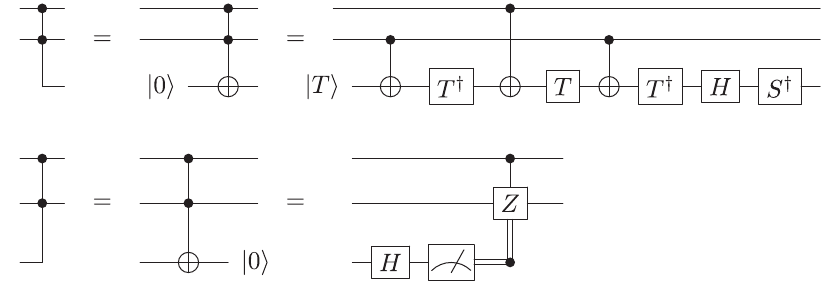
FIG. 4. Computing and uncomputing AND operations, defined in terms of Toffoli gates and in terms of Clifford þ T gates [60]. Computing an AND consumes 4 j T i states and is equivalent to applying a Toffoli gate to a target qubit known to be j 0 i . Uncomputing an AND consumes no j T i states and is equivalent to applying a Toffoli gate to a target qubit guaranteed to end up in the j 0 i state. Drawing AND operations as “ corners ” instead of as ⊕ symbols is a visual cue that the target qubit will be (or was) OFF after (before) the operation. This is worth highlighting because it affects the T count of synthesizing the operation and means that the target is available for reuse as an ancilla in later operations.